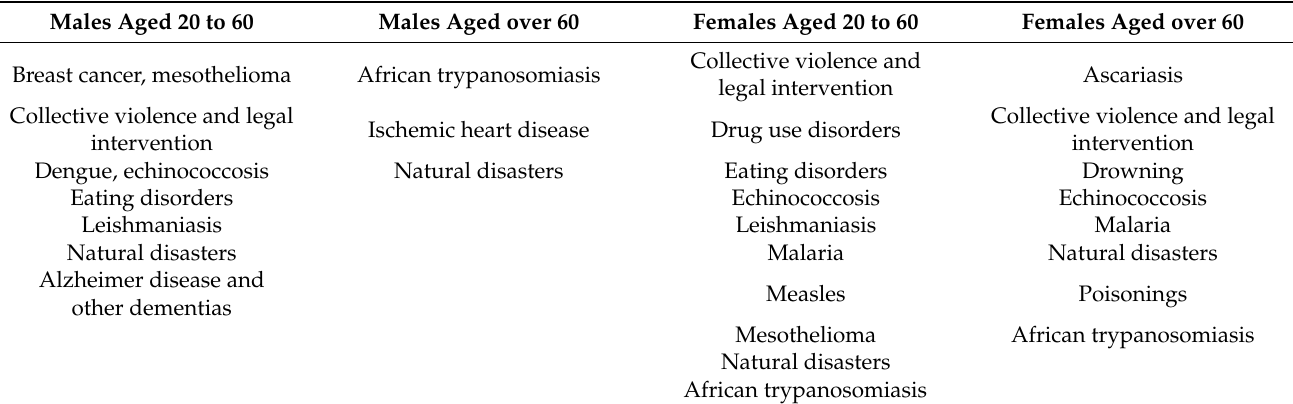
Table 10. Outlier